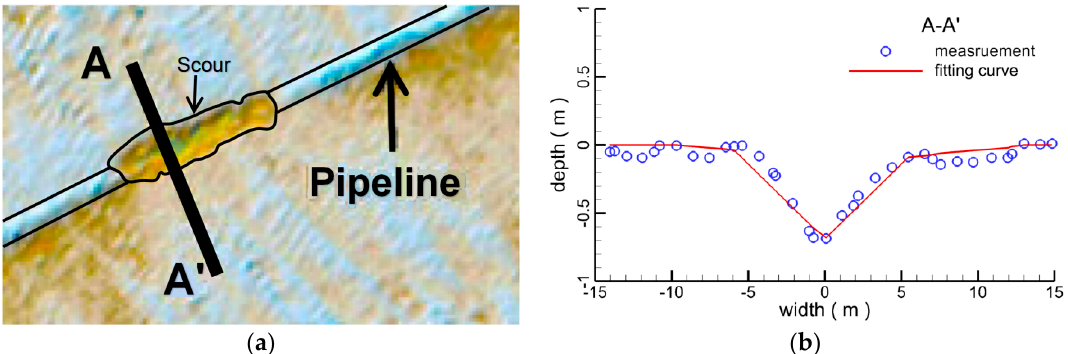
Figure 23. Scour morphology around the submarine pipeline. ( a ) Surface map of scour pit. ( b ) The measurement data of scour hole.